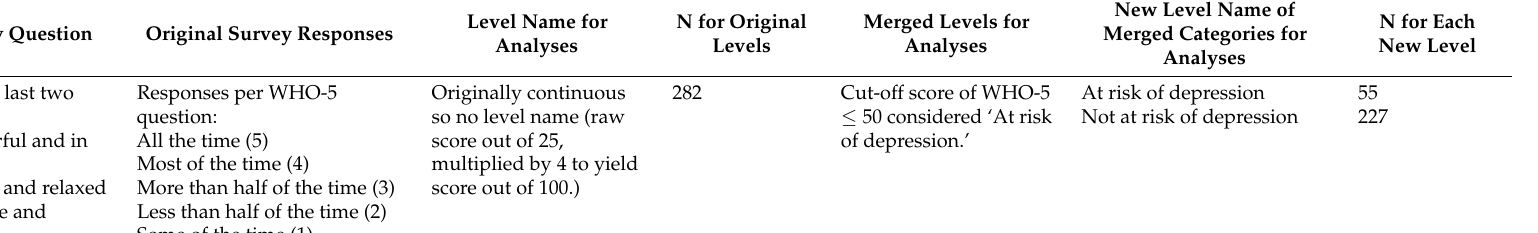
Table A1. Summary table of variables and their derivation from the original survey questions. Repeat surveys and those that were missing responses or contained “I do not know” responses to any of the survey questions listed here were removed before analyses. The resulting level of the merged categories ‘none,’ ‘primary’ and ‘other’ for the variable ‘educational background’ was also dropped due to its low sample size ( n = 7). Those seven observations are, therefore, not considered in the summaries of the other predictor variables, resulting in a total of 282 observations used in